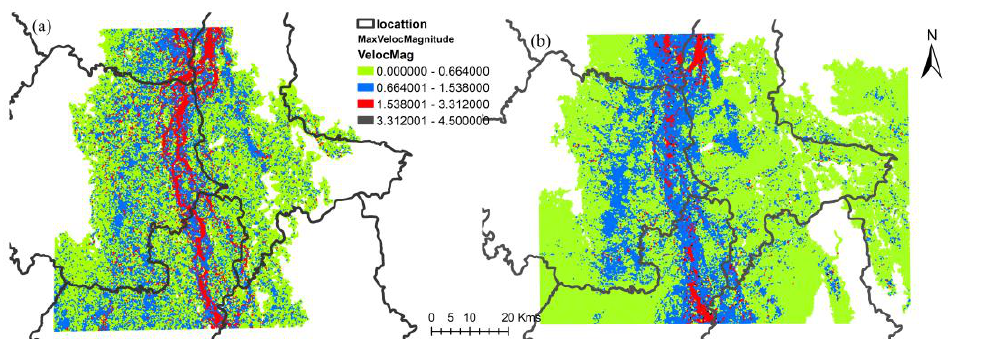
Fig. 7. Flood hazard mapping based on velocity, (a) for 2 yrs return period, (b) for 100 yrs return